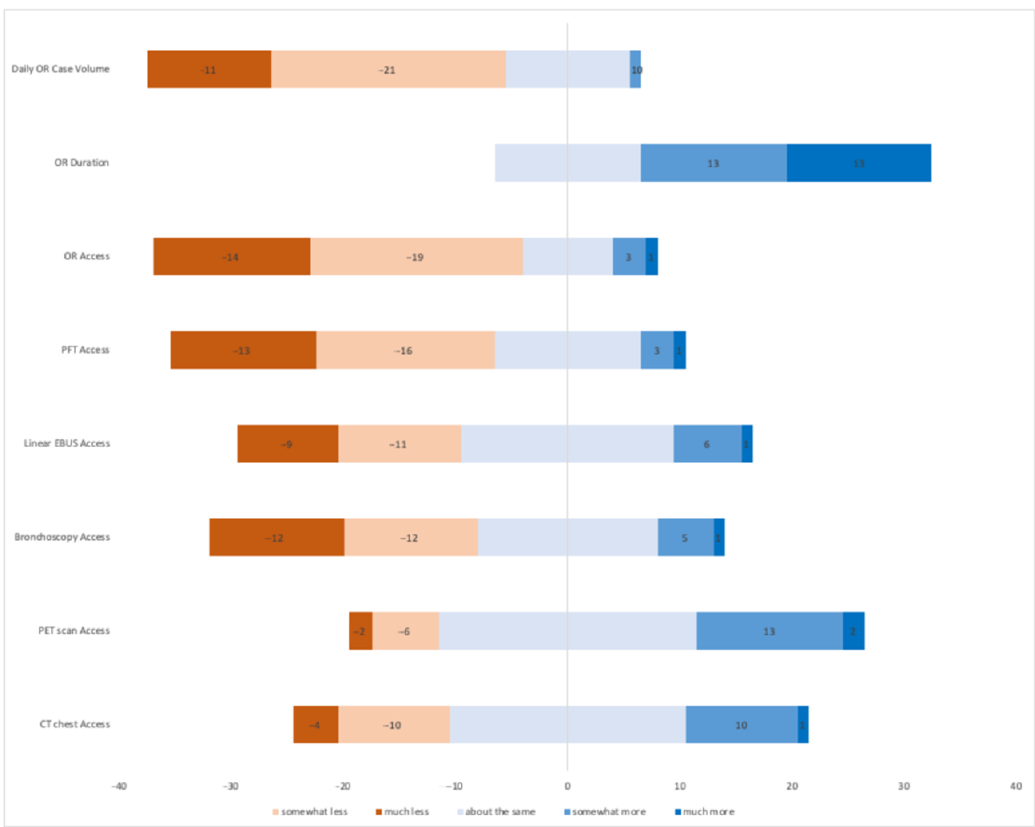
Figure 1. Diverging stacked bar chart displaying thoracic surgeon impressions regarding the impact of COVID-19 on lung cancer preoperative and operative variables. The X -axis displays respondent count, while the Y -axis lists the variable for thoracic surgeon